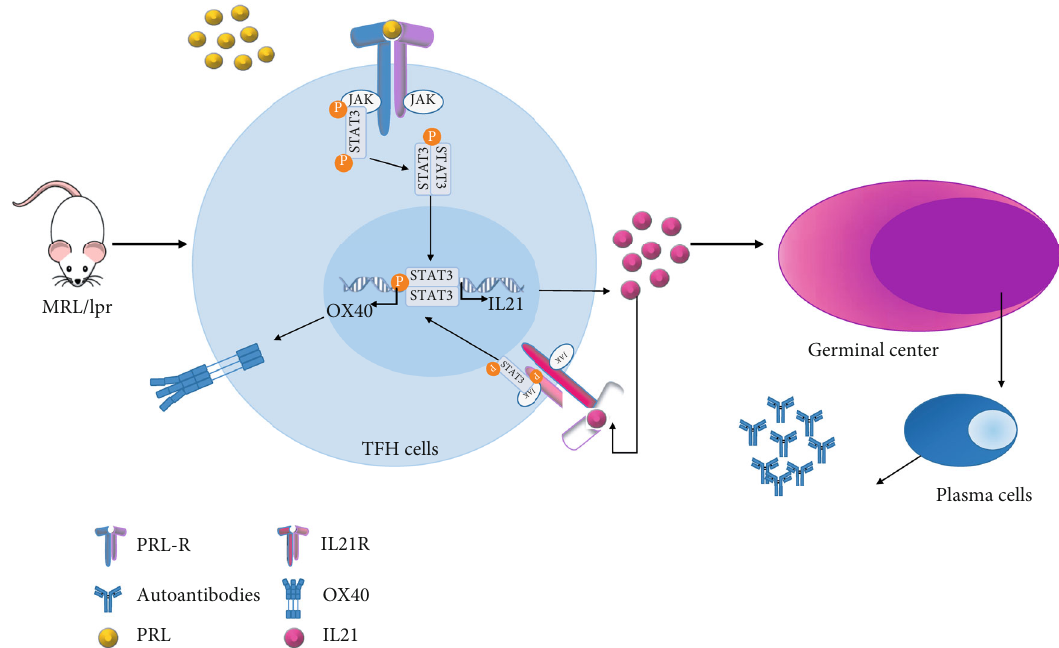
Figure 6: Working model of the mechanism of action of PRL in T display increased levels of PRL receptor expression restrictive to the long isoform, together with higher levels of serum PRL. This combination results in the heightened activation of STAT3, as well as the increase in OX40 expression and IL21 secretion, which increase the activation of T cells favoring the formation of germinal centers, generation of autoreactive plasma cells and increased levels of autoantibodies, with FH enhanced tissue damage due to the immune complex deposition that characterizes